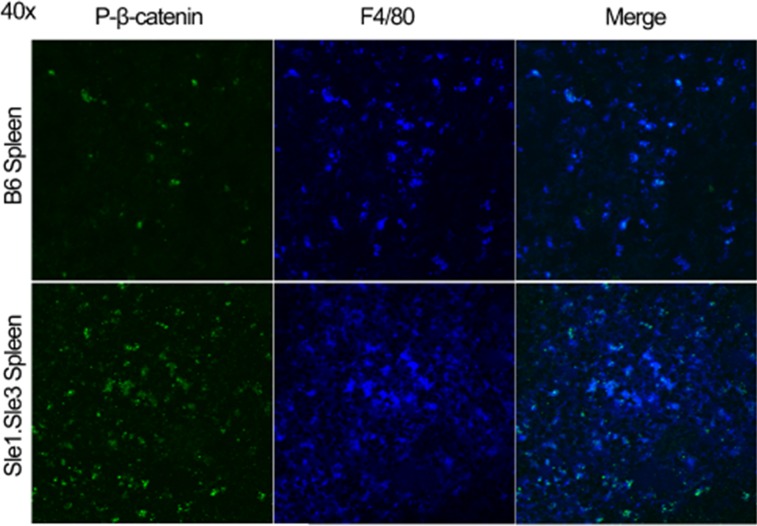
Lupus-prone F4/80-positive splenocytes express reduced β-catenin signaling.Spleens from 4 month old healthy B6 and lupus-prone B6.Sle1.Sle3 mice were sectioned and stained for phosphorylated (i.e. inactivated) β-catenin protein (green) and F4/80 (blue). These inactivated β-catenin proteins co-localized with F4/80-positive splenocytes (i.e. macrophages).